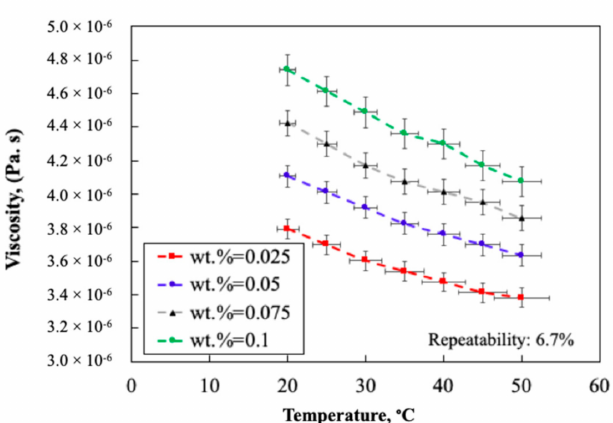
Figure 8. Dependence of viscosity of nanofluids on temperature for di ff erent concentrations of CNPs in